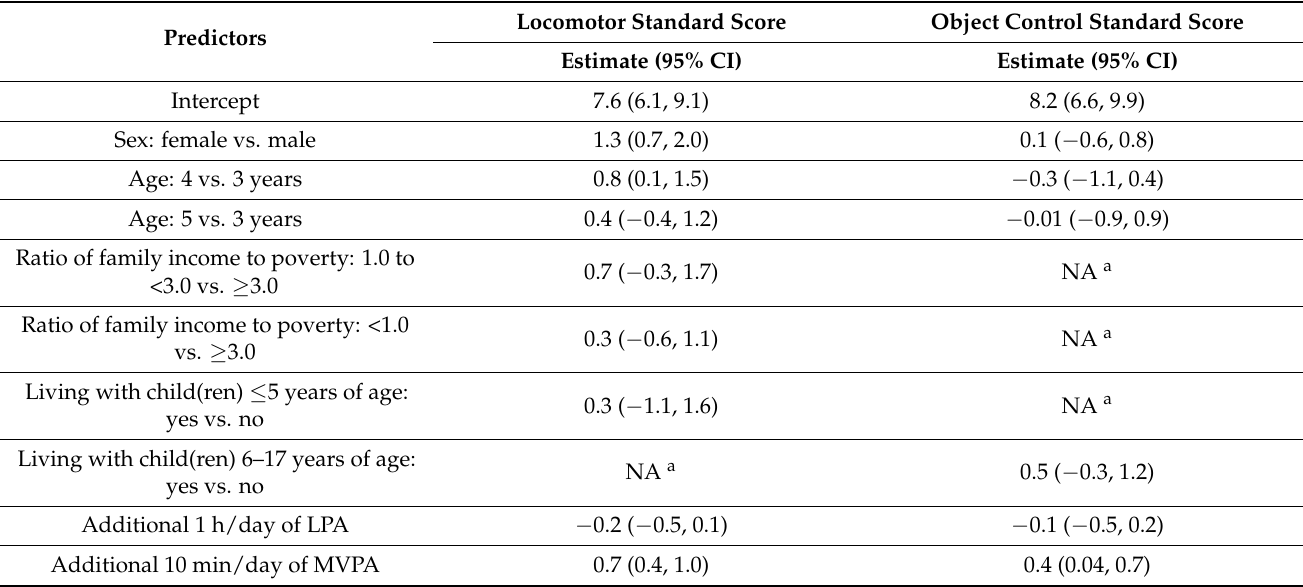
Table 2. Multivariable linear regression models for locomotor and object control standard scores